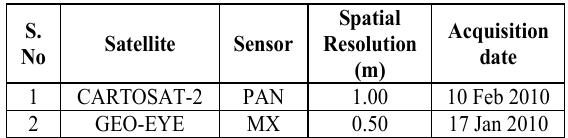
Table 1. Details of satellite images